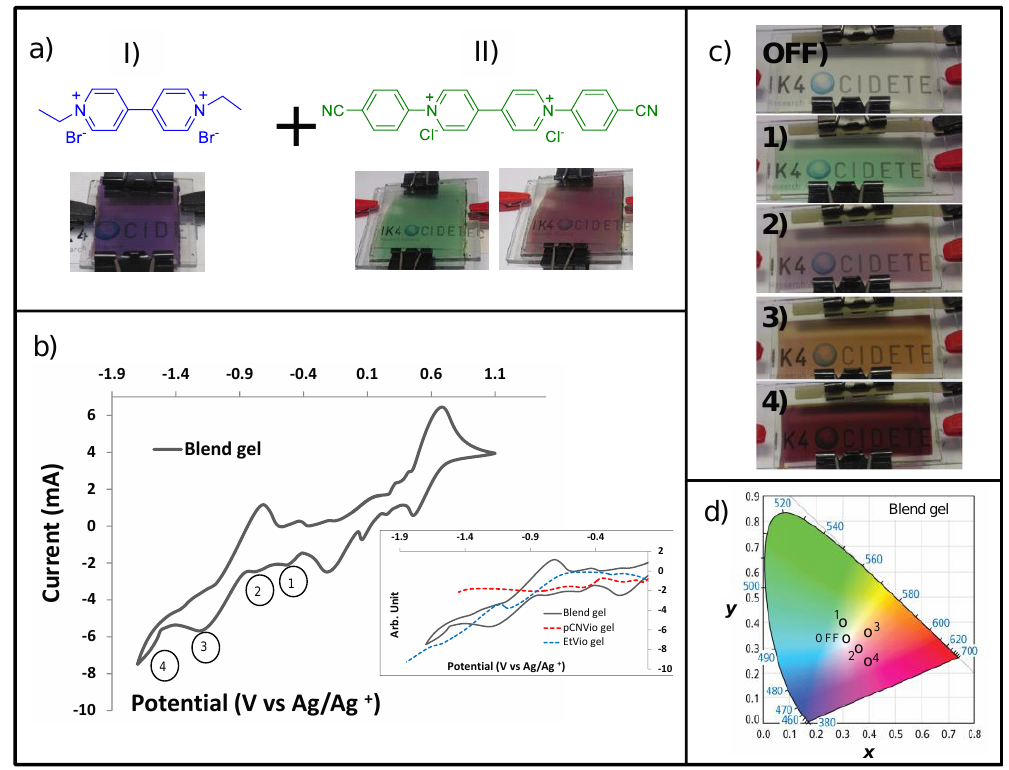
Figure 13. ( a ) Single-viologen–based EC systems: ( I ) chemical structures of employed viologens, monoelectrochromic ethyl viologen dibromide and ( II ) bielectrochromic p -cyanophenyl viologen dichloride ( p -CV) (top), with photographs of the corresponding ECDs at colored states (bottom). ( b –